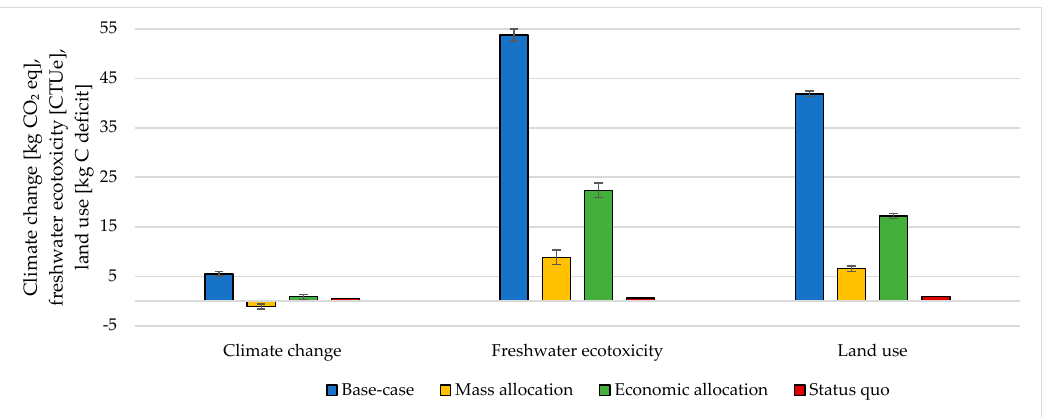
Figure 6. Climate change, freshwater ecotoxicity, and land use assessment for 1 kg SNG production under different MU methodologies: base-case, mass allocation, economic allocation, and status quo.